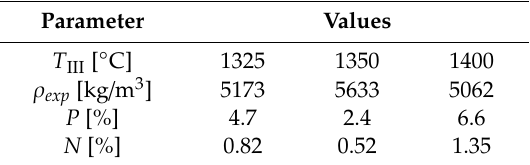
Table 1. Comparison of actual density ( ρ exp), water absorption (N), and porosity (P) of lanthanum barium titanate (BLT4) ceramics depending on the third sintering temperature